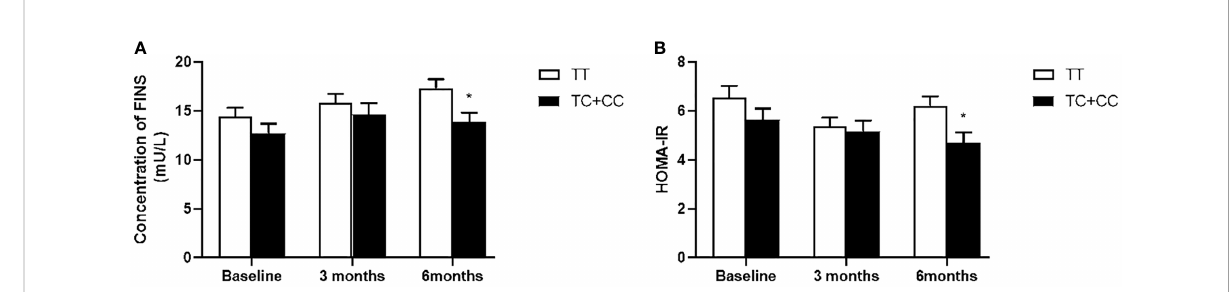
FIGURE 1 Comparison of fasting serum insulin (FINS) (A) and homeostasis model assessment for insulin resistance (HOMA-IR) (B) between T2DM patients with the TT genotype (n = 62) and those with TC and CC genotypes (n = 43) genotypes of PPARD rs2016520 in T2DM patients before, at 3 months and at 6 months of exenatide treatment. Data are expressed as the mean ± SE, * P <0.05 compared with TT genotype group (n= 105).